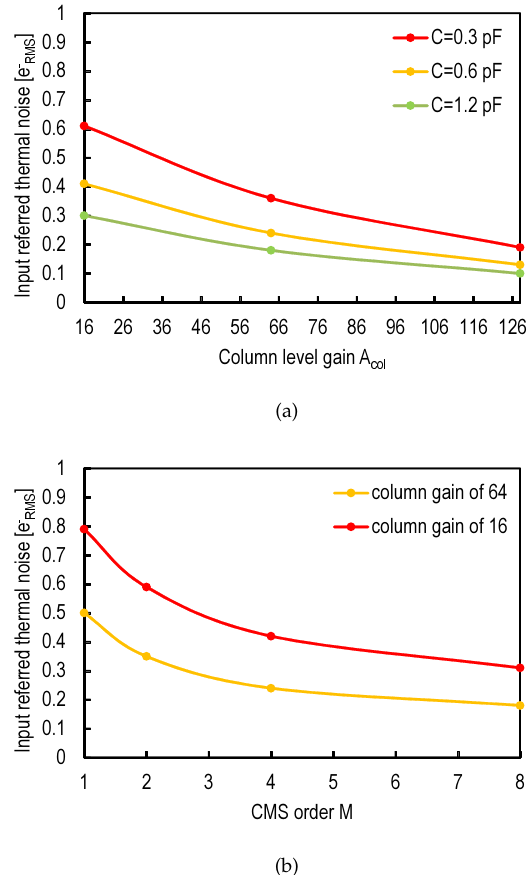
Figure 8. Input-referred thermal noise, obtained from transient noise simulations, of a CIS readout chain, with a 4T pixel (standard NMOS source follower) with a conversion gain of 85 µ V/ e − , column amplification (closed loop gain with the operational transconductance amplifier (OTA)) and CMS implemented with the analog circuit presented in [17], as a function of: ( a ) the column-level gain A col for different values of C and a simple CDS (M = 1); ( b ) the CMS order M for different values of the column-level gain A col and C = 0.2